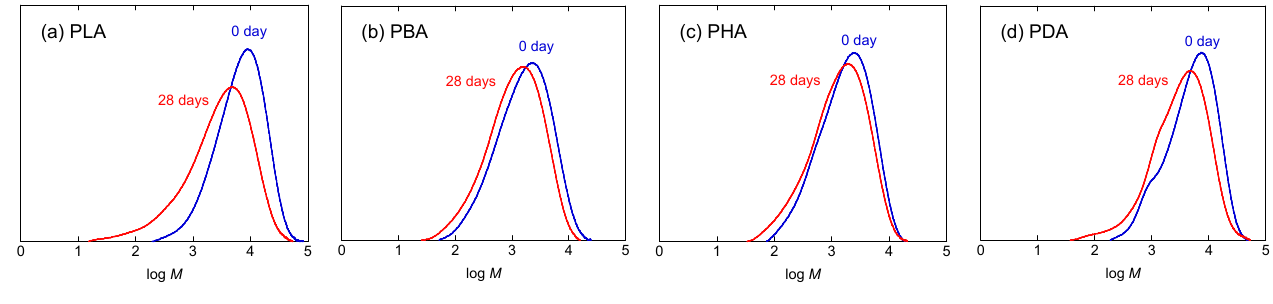
( b ), and molecular weight distribution ( M n